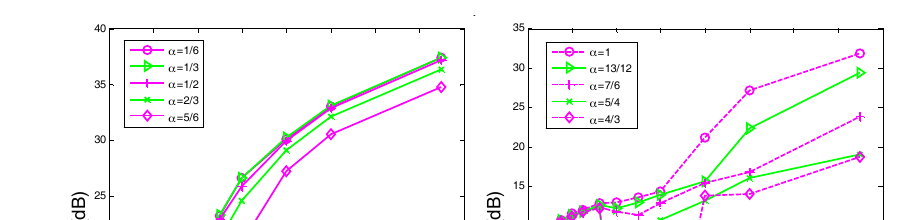
, (cid:2875) , (cid:2870) , (cid:2871) , (cid:2873) } . (cid:110) (cid:111) 1 (cid:2870) (cid:2869)(cid:2870) (cid:2871) (cid:2872) (cid:2874) , 7 , 2 , 3 , 5 . 2 3 6 12 4